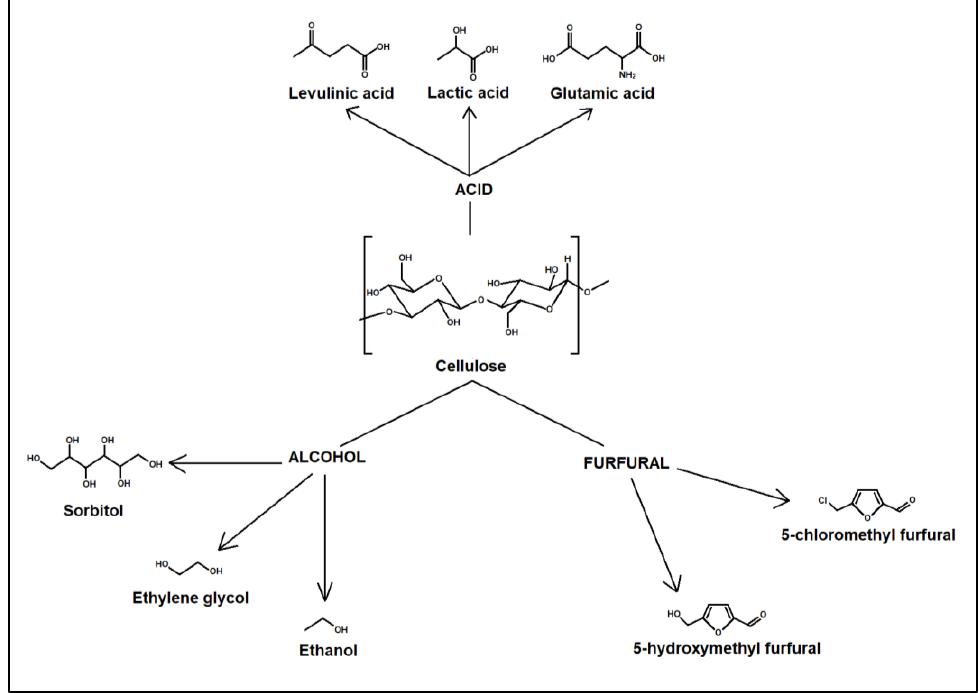
Figure 1. Platform chemicals that can be produced from cellulose.